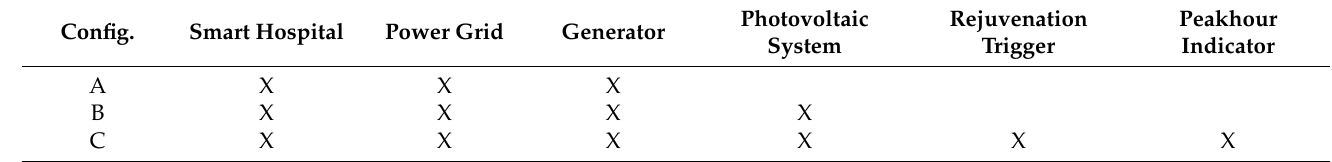
Table 2. Operational configurations.